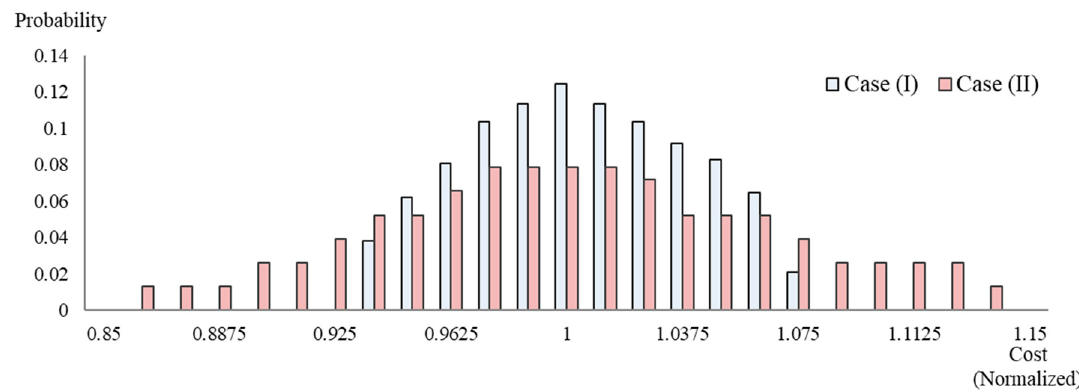
Figure 5. Probabilistic distribution of the total costs based on fixed investment decisions in year 2027 owing to each case ( x -axis: normalized total costs based on each case; average value is 1, y -axis: probability).